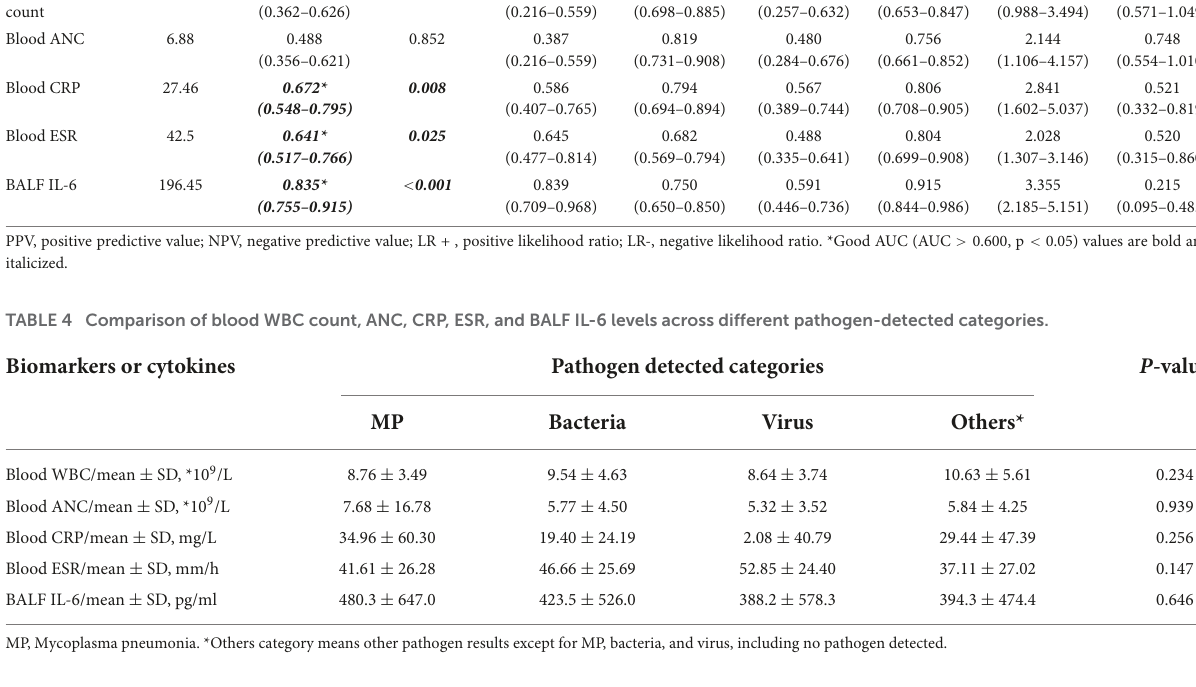
TABLE 5 Comparison of biomarkers or cytokines between certain pathogen and non-pathogen groups.